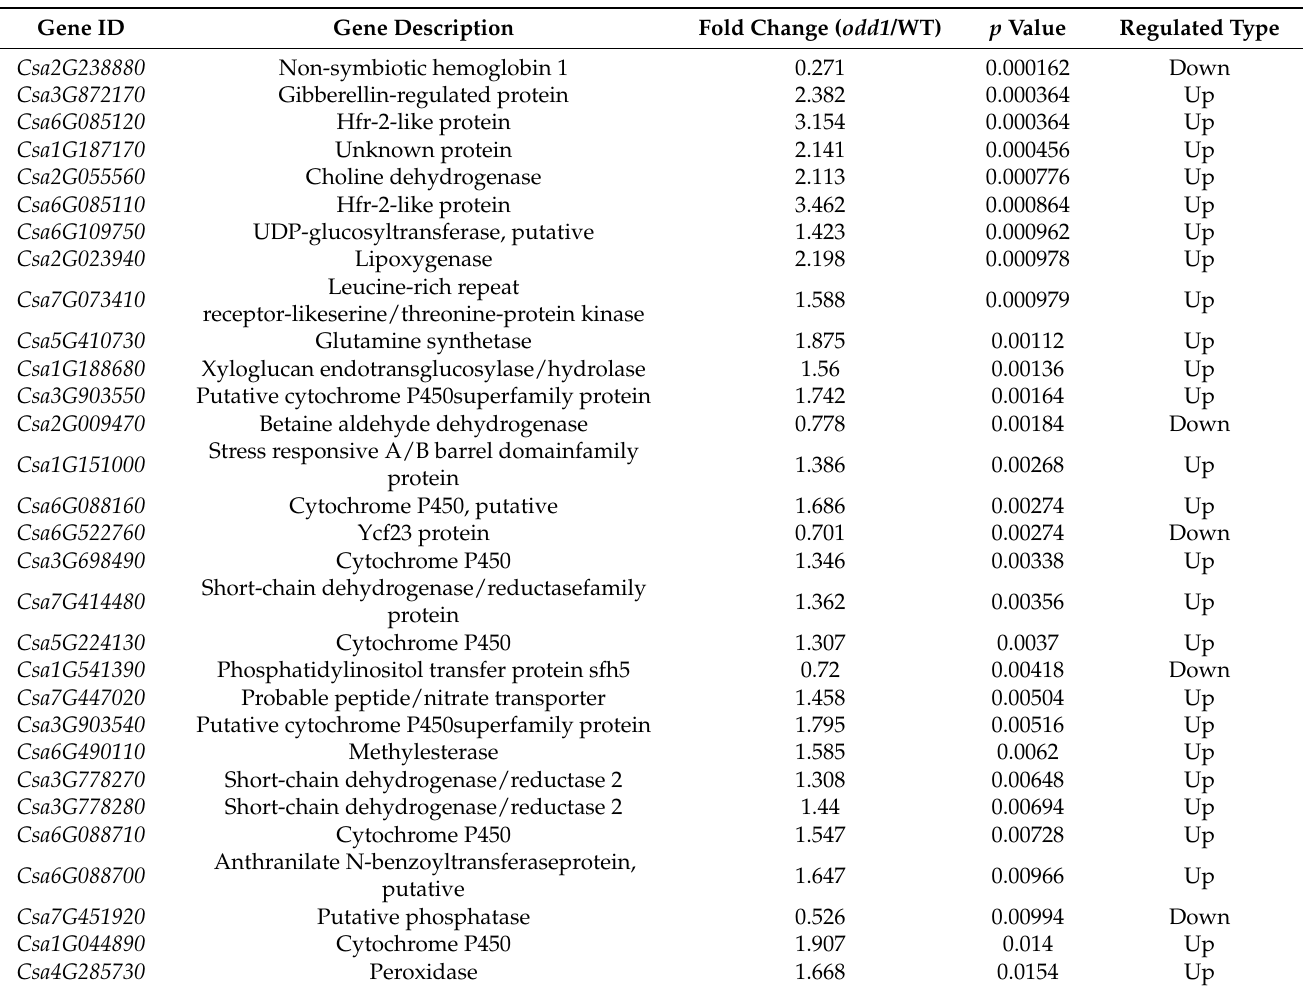
Figure 19. Combined transcriptome and proteome analysis of odd1 . ( A ) The correlation analysis of abundance changes from transcriptome to proteome. ( B ) Comparison of significant differences between the transcriptome and proteome. T: transcript; P: protein species; N: no change; U: up-accumulation; D: down-accumulation. Table 5. List of the 42 cor-DEG-DEP genes that were regulated at both transcriptional and translational levels.